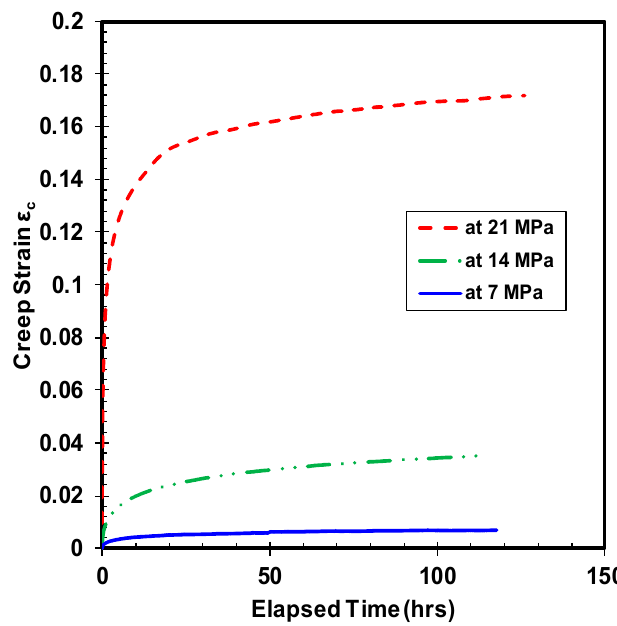
Figure 3. Creep strain under different loads at ambient temperature.